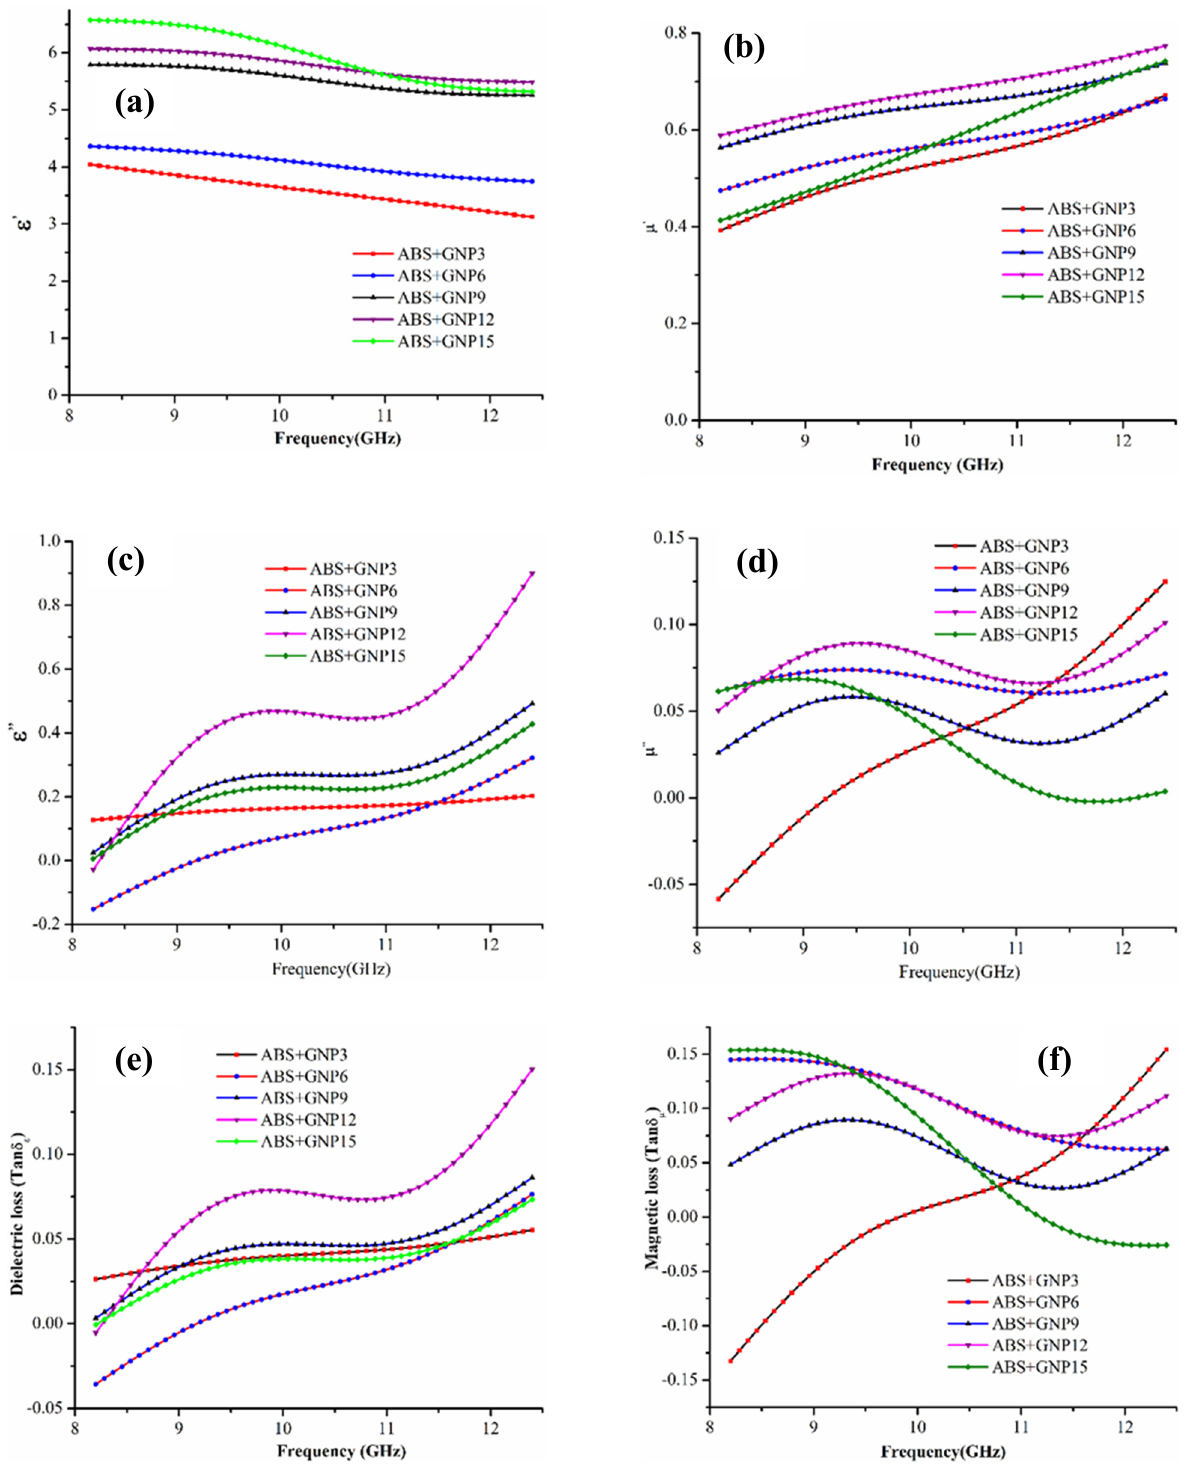
Figure 11. Frequency-dependent behavior of the ABS+GNP nanocomposites for ( a ) real and ( c ) imaginary parts of permittivity, ( b ) real and ( d ) imaginary parts of permeability, and corresponding ( e ) dielectric and ( f ) magnetic losses.